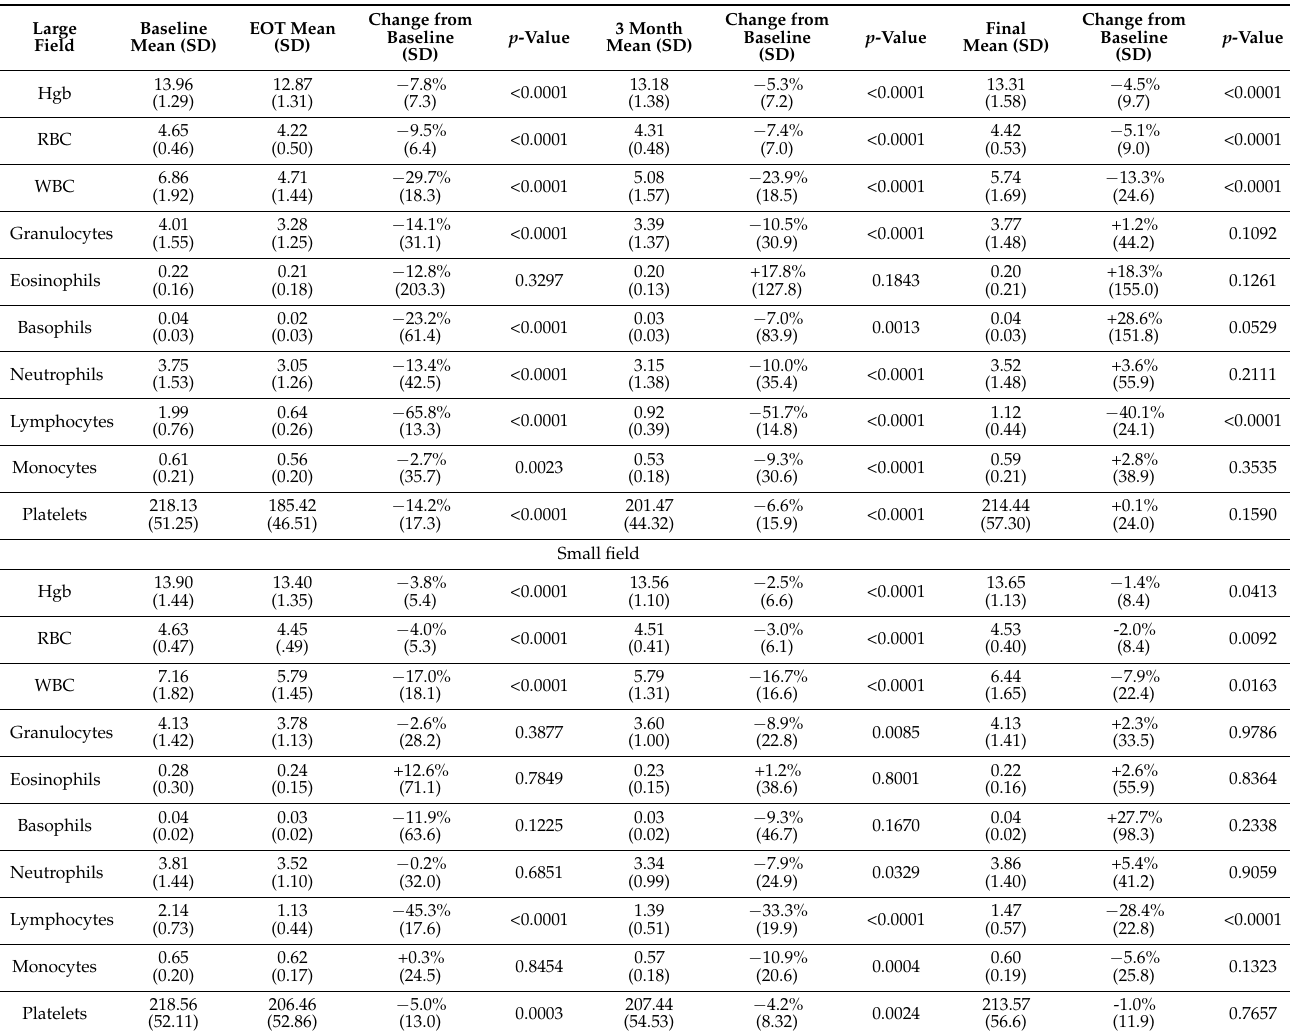
Table 4. Blood count changes based on field size. Large field indicates pelvis treatment covering the lymphatic (followed by a small field boost). Small field is treatment for the prostate/prostate fossa only.